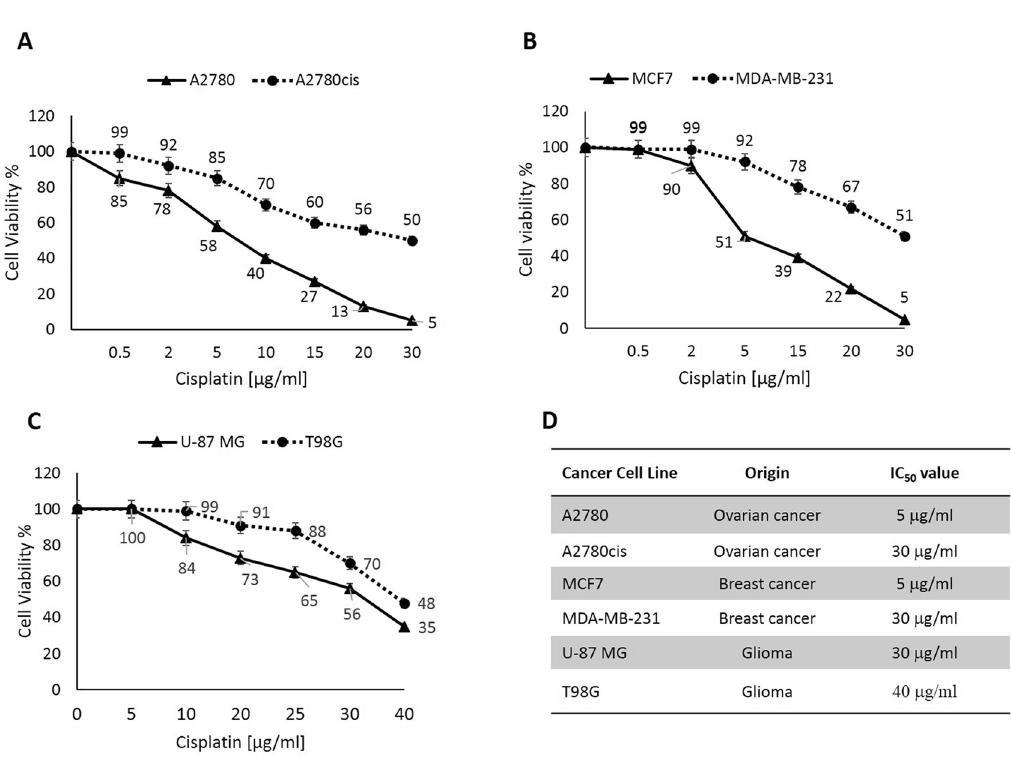
Figure 4. Cancer cells exhibit different resistance to cisplatin-induced cytotoxicity. ( A ): A2780 and A2780cis cells. ( B ): MCF7 and MDA-MB-231 cells. ( C ) U-87 MG and T98G cells. ( D ) Table showed IC 50 s of the studied cell